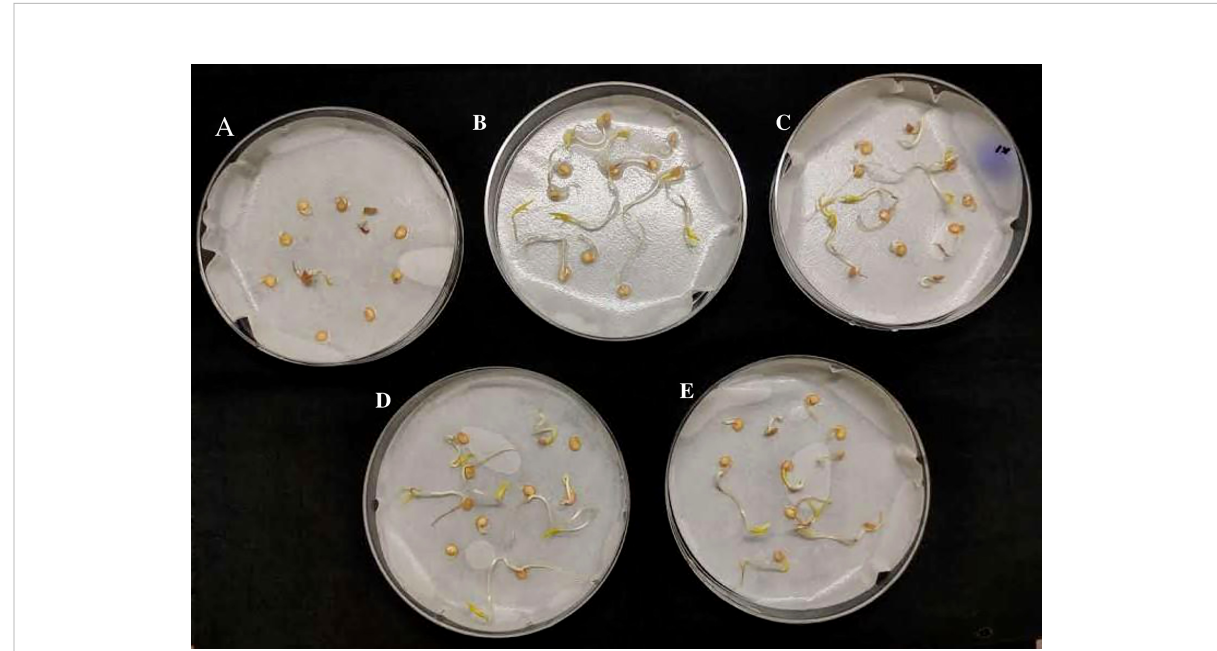
FIGURE 7 Seed germination plate assay in chili seeds, (A) Control; (B, C) . - chili seeds treated with Streptomyces sp. VCLA3; (D, E) - chili seeds treated with Streptomyces sp.